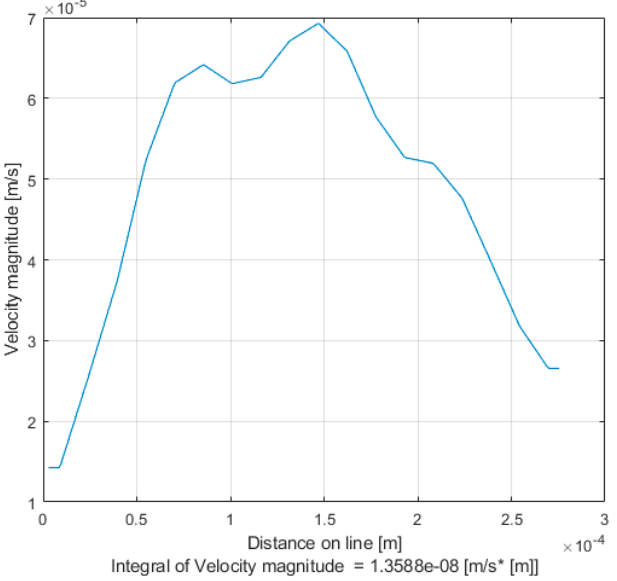
Figure 27. Velocity pro fi le extraction from the middle of the fi rst electrode for the 10 µm diameter particle study at 4 A and 10 Hz.